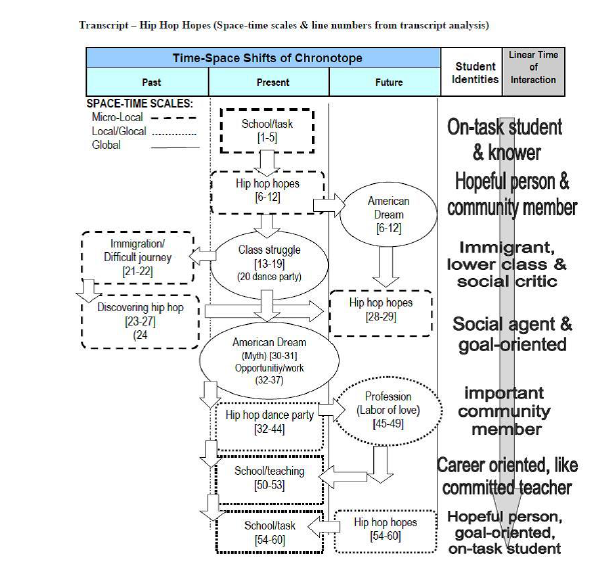
FIGURE 1. MAPPING IMMIGRANT STUDENT IDENTITIES IN CLASSROOM